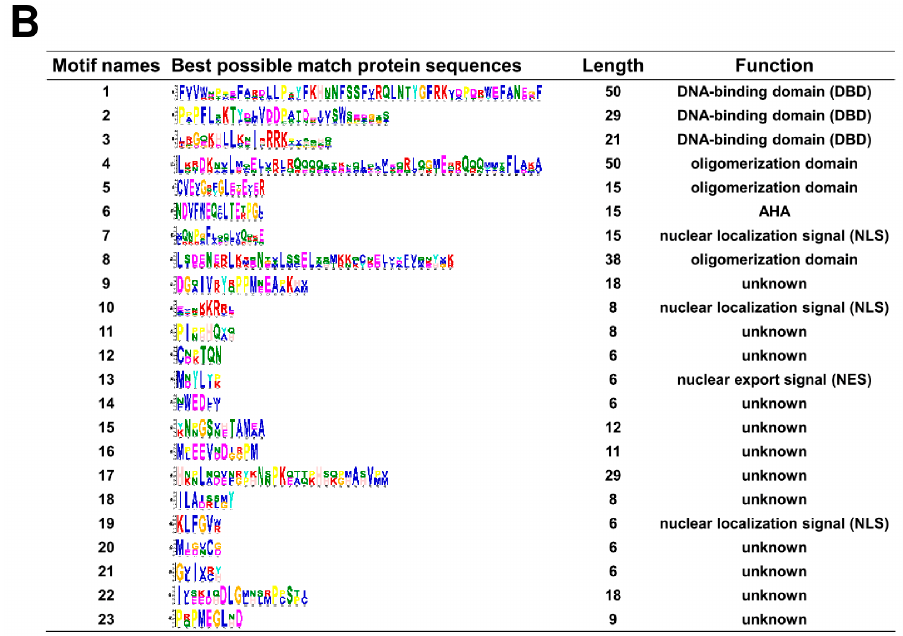
Figure 2. Motifs identified using MEME tools in FaTHSFs. ( A ) The motif location and combined p -value of FaTHSFs are shown and denoted by rectangles with different colors. The black closed bracket on the right of the figure shows genes clustering into classes A and B; ( B ) Possible amino acid sequences of Motifs 1–23 identified using MEME tools for FaTHSFs.